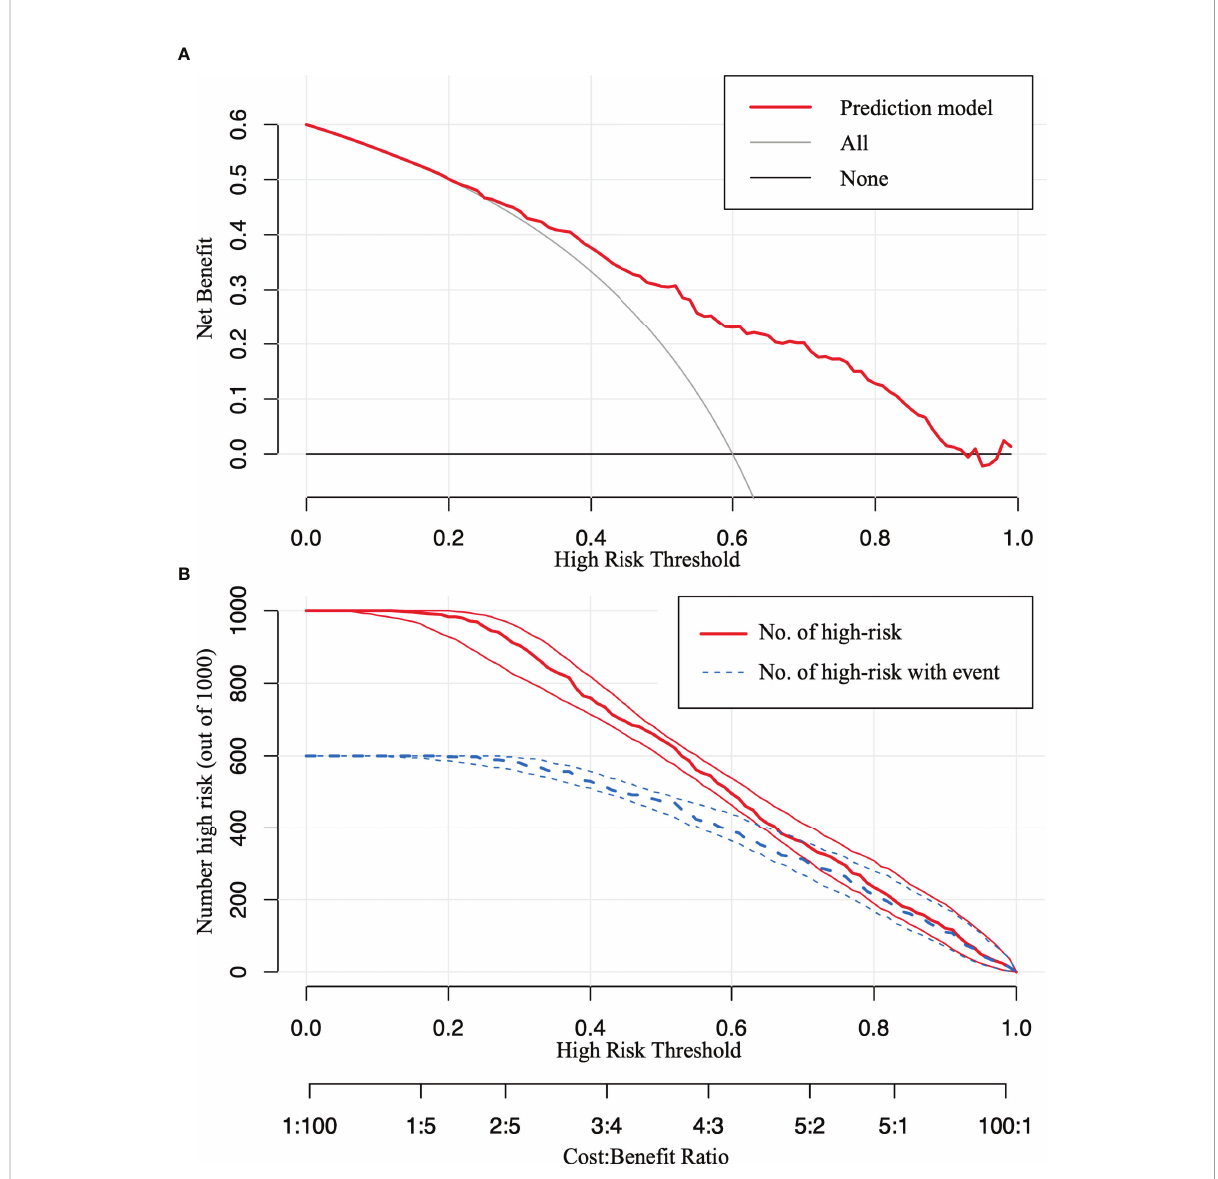
FIGURE 5 The decision curve analysis (DCA) and the clinical impact curve (CIC). (A) The DCA in the validation set. (B) The CIC in the validation set. The red curve [number of high-risk papillary thyroid carcinoma (PTC) individuals] indicates the number of people who are classi fi ed as positive (low-risk PTC) by the model at each threshold probability; the blue curve (number of high-risk PTC individuals with an outcome) represents the number of true positives at each threshold